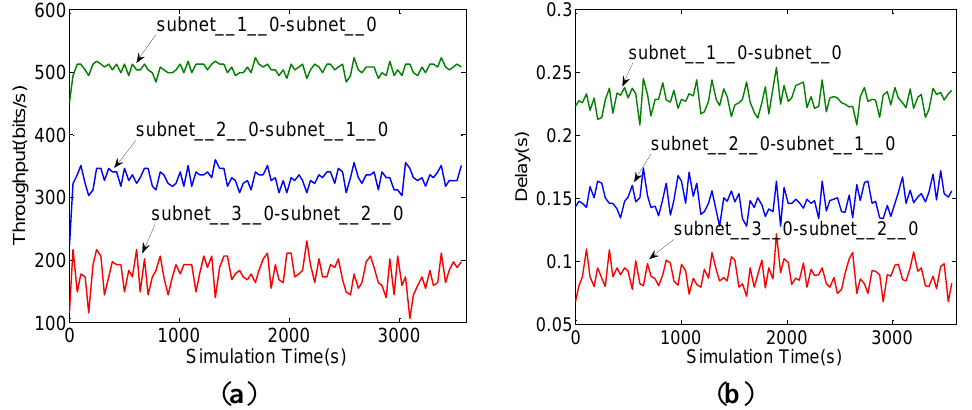
Figure 12. Simulation results of links between centre nodes. ( a ) Throughput between central nodes; ( b ) Delay between central